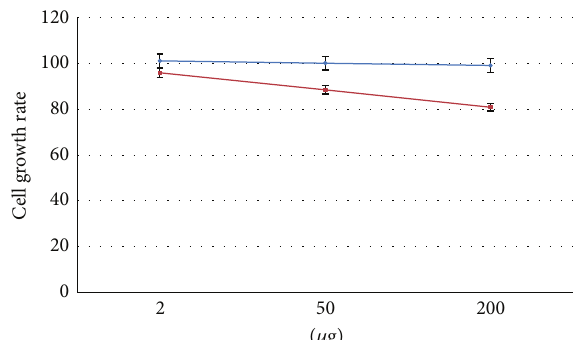
Figure 1: Cell growth rate after 24 h of treatment with different amount of sponge extracts in normal human breast epithelial cells, MCF-10A (blue), and human breast cancer cells, MCF-7 (red).